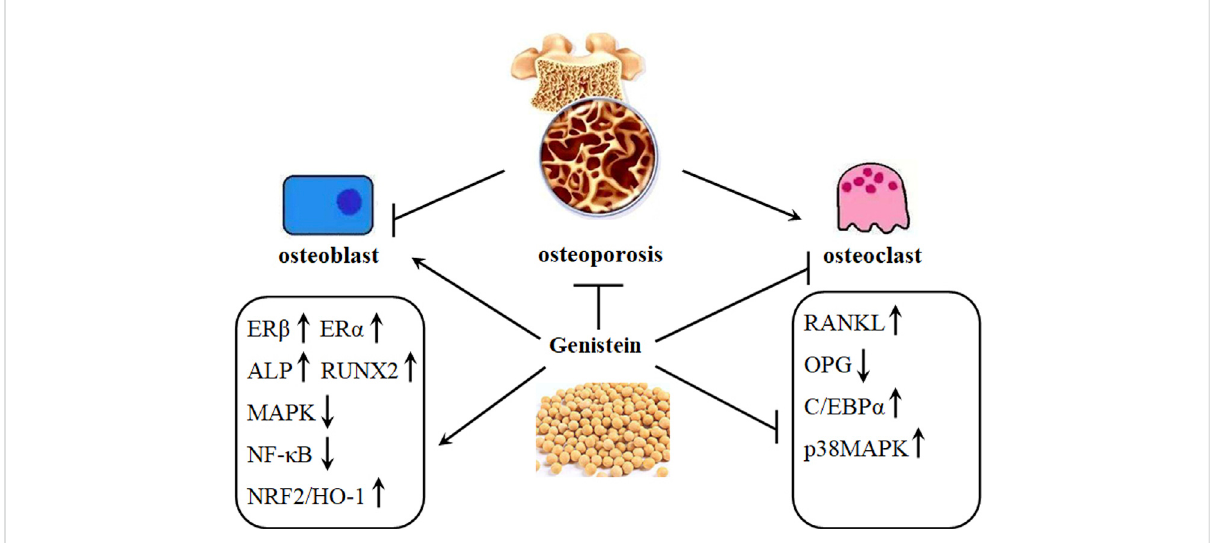
FIGURE 2 Genisteinprotectsagainstosteoporosis development.Osteoporosisischaracterizedbydecreased activityofosteoblasts andincreasedactivity of osteoclasts. This imbalance can be restored by genistein, as shown by increased expression of ER β , ER α , ALP, RUNX2, and NRF2/HO-1 and decreased expression of MAPK, NF- κ B, C/EBP α , and RANKL/OPG